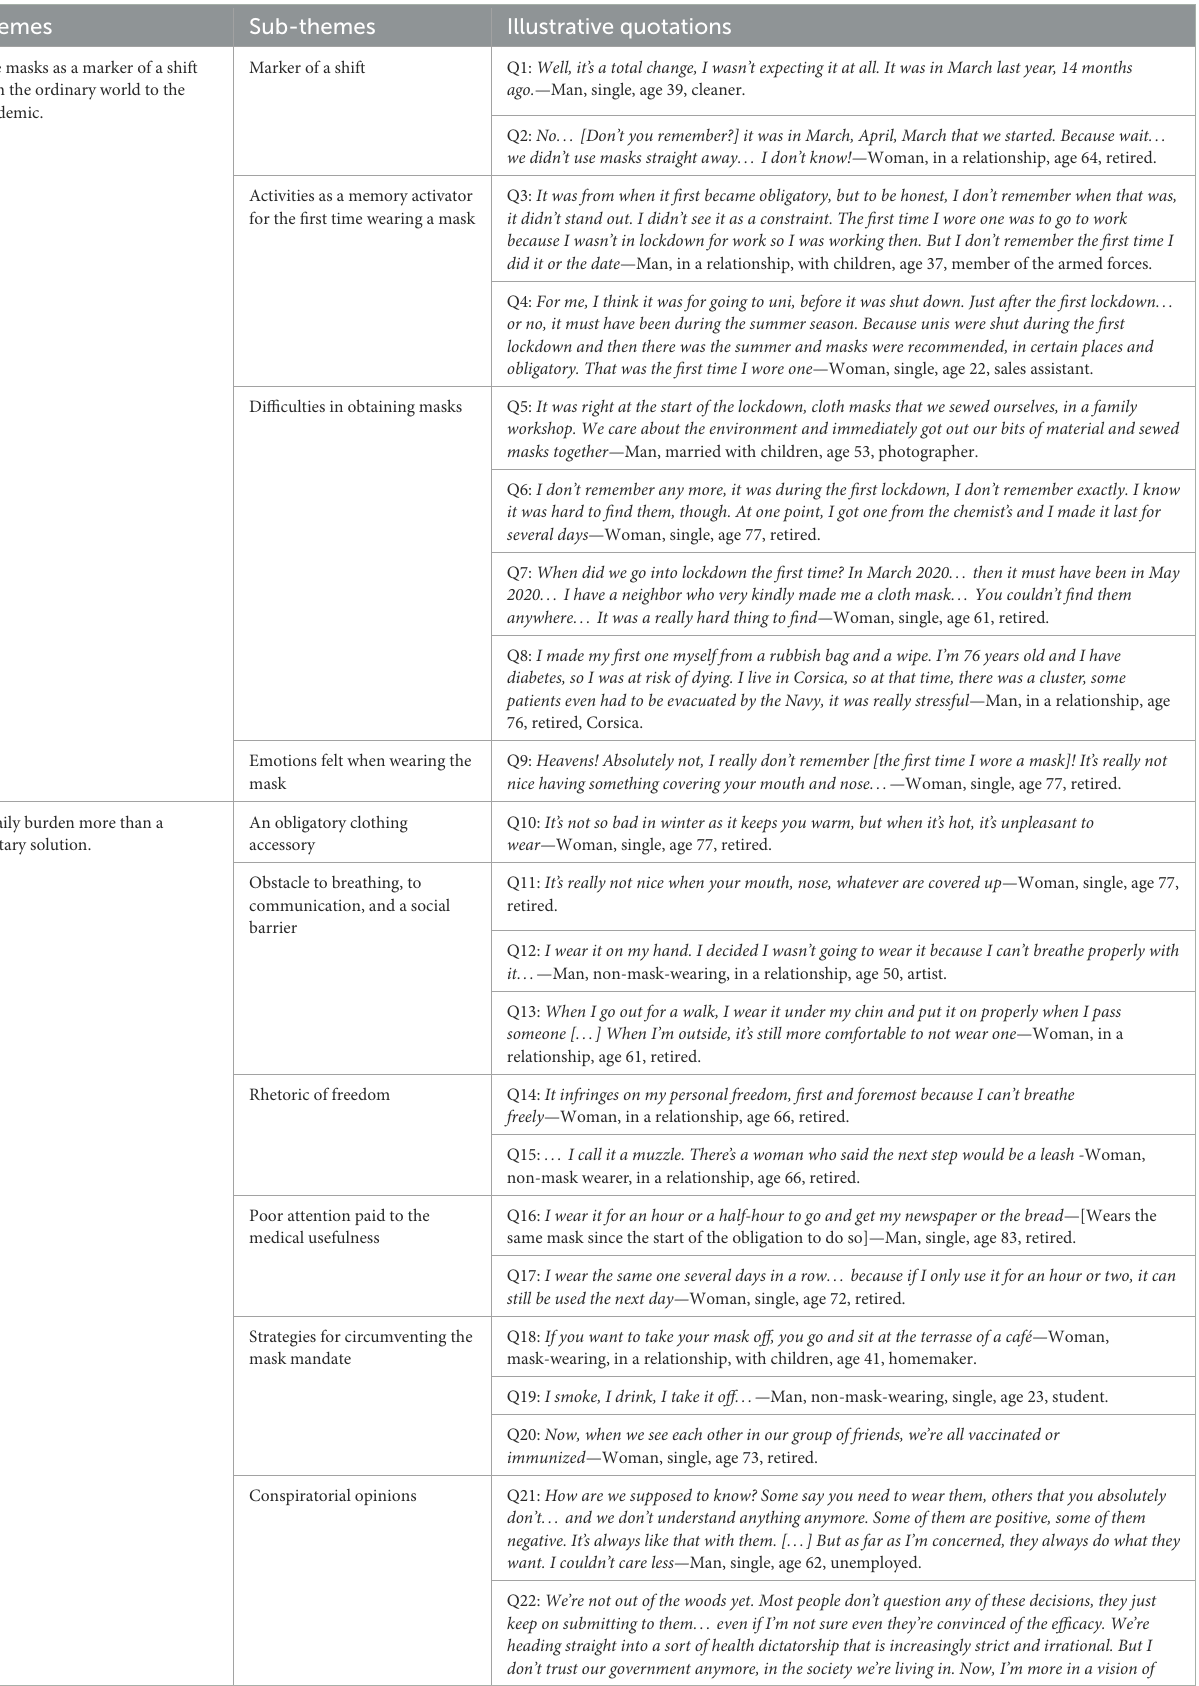
Face masks as a marker of a shift from the ordinary world to the